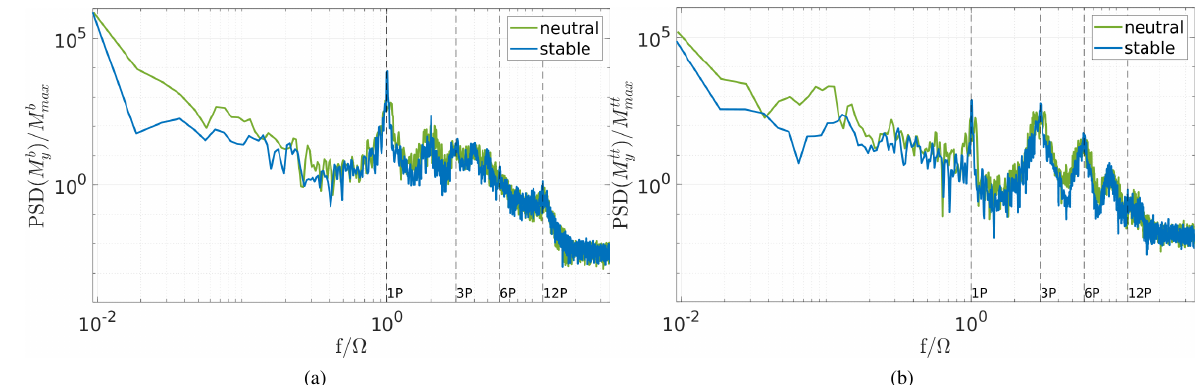
Figure 18. Comparison of the (a) blade root bending moments out of plane M b y and (b) tower top fore–aft bending moment M tt y for the stable and neutral simulation. The data are normalised by the maximum value of the blade root bending and tower top bending moments, and the frequency is normalised by the rotor